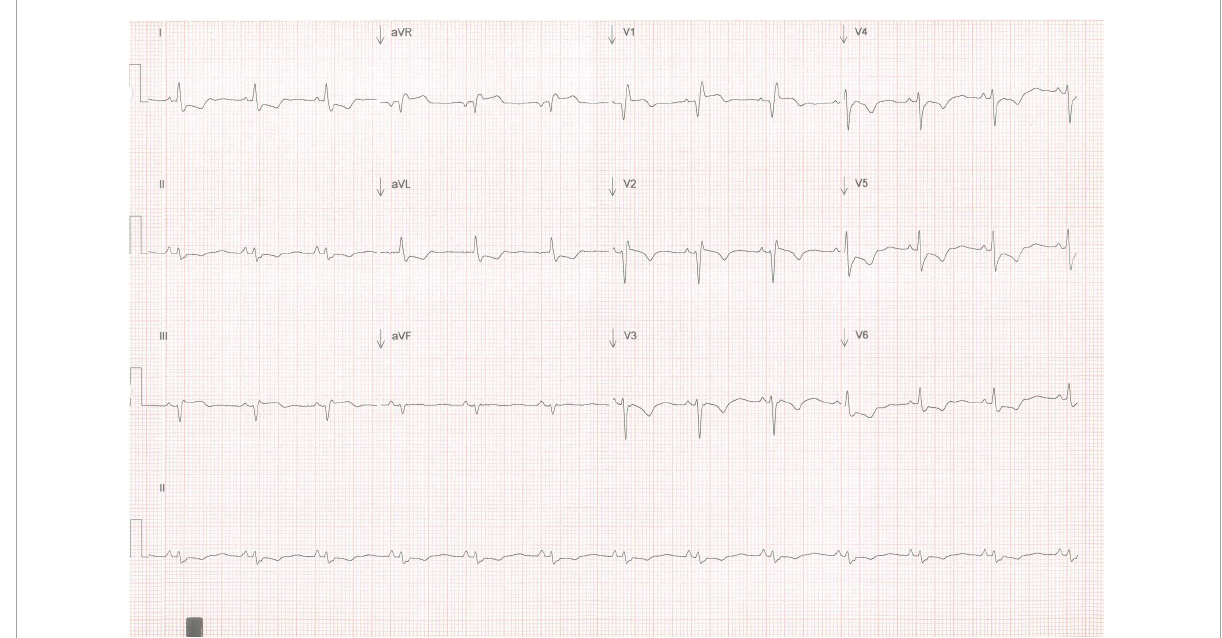
FIGURE1 Twelve-lead EKG showing high-risk ischemic features. ST-segment elevation is observed in aVR and V1, as well as ST-segment depression in six different leads (V3, V4, V5, V6, DI,